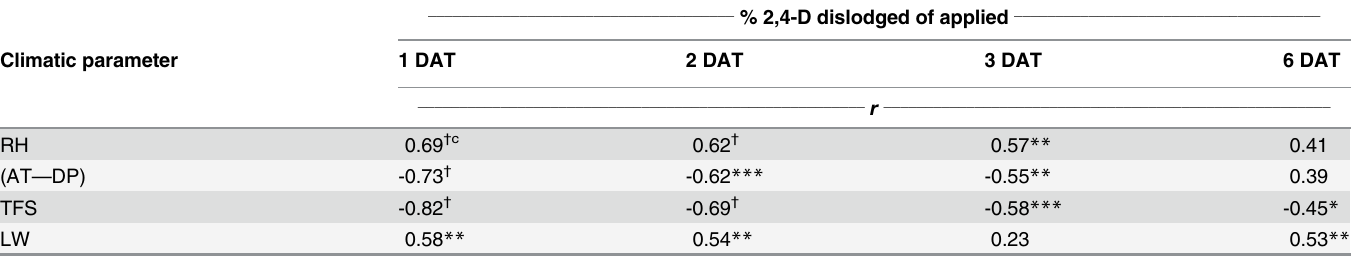
a Abbreviations: DAT, d after treatment; RH, relative humidity; AT, air temperature; DP, dew point; TFS, time from sunrise; LW, leaf wetness. b Climatic conditions recorded on site at the Lake Wheeler Turfgrass Field Lab (Raleigh, NC, USA). c † , *** , ** and * denote signi fi cance at P < 0.0001, 0.001, 0.01 and 0.05,